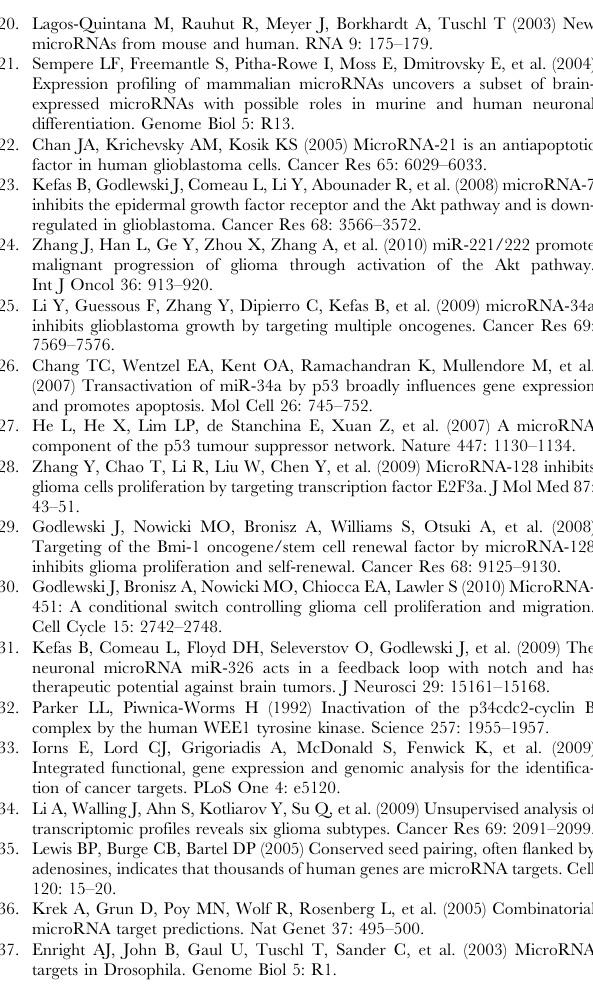
Table S4 List of 128 miRNAs that significantly interact with a gene (P , 0.05). In particular, we counted the number of significant interactions (N) and indicate if the underlying miR is over ( X , lg 2 fold change . 1) or under ( Y , lg 2 fold change ,2 1) expressed or largely unchanged ( , ) in